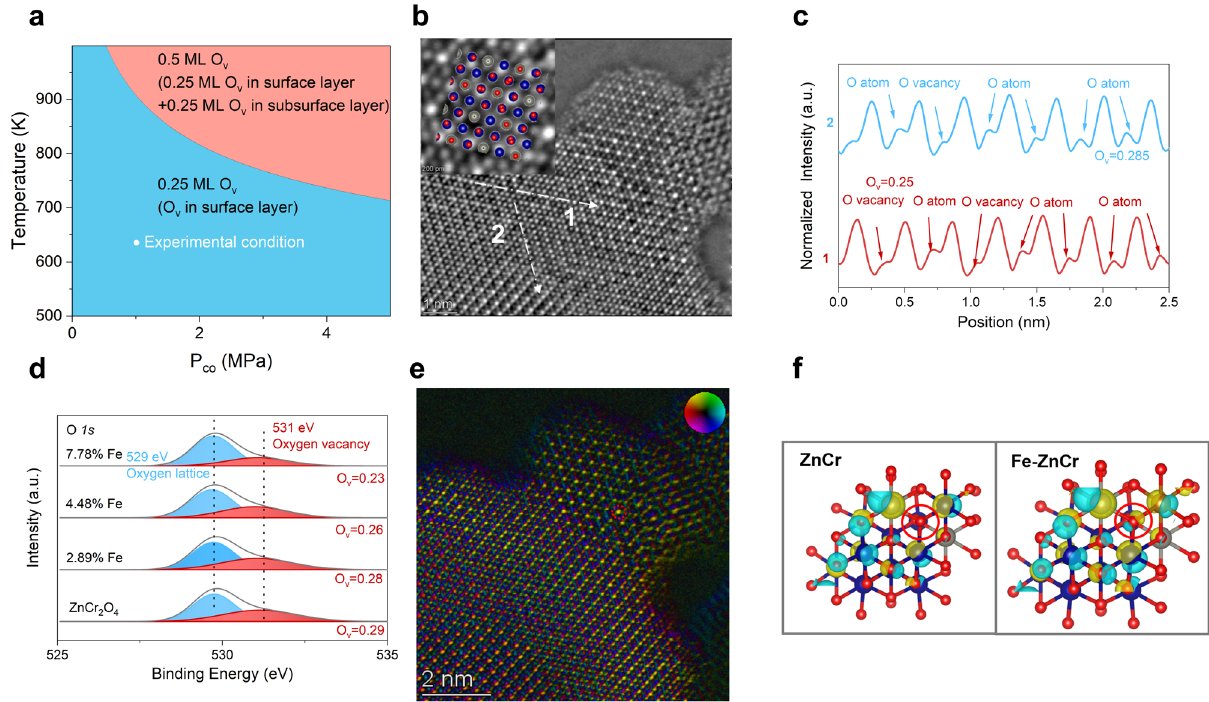
fi eld XPS spectra of ZnCr 2 O 4 and different Fe-Zn/Cr samples. e Projected electric strengthand vectormapof4.48%Fe-Zn/Cr. f Differentialchargedensity(cyanand yellow represent charge depletion and accumulation, respectively; the cutoff of the density-difference isosurface is 0.11eÅ − 3